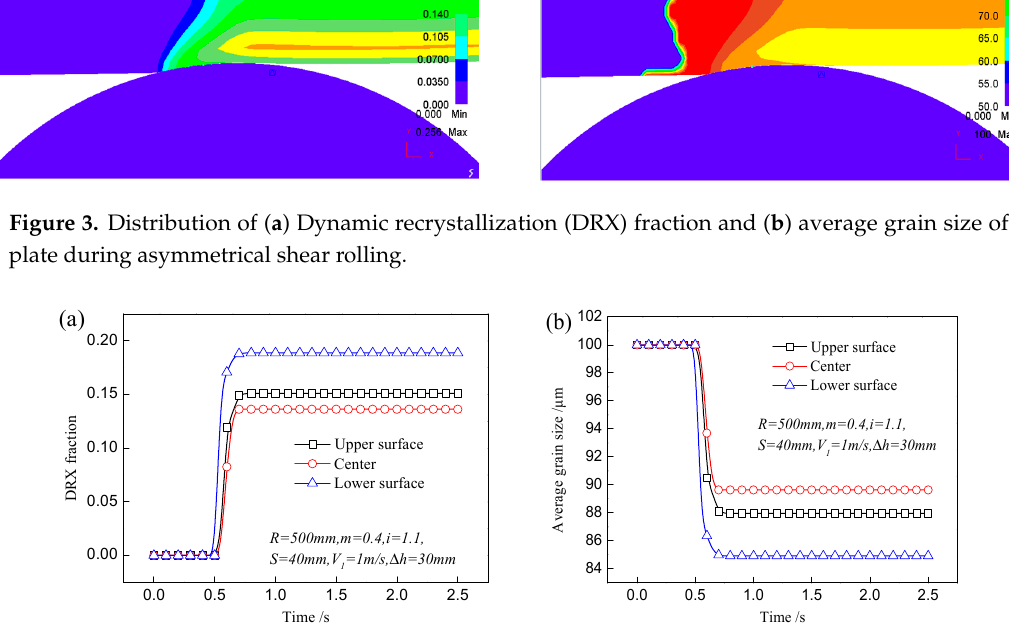
Figure 4. Variation of ( a ) DRX fraction and ( b ) average grain size at different positions of plate.